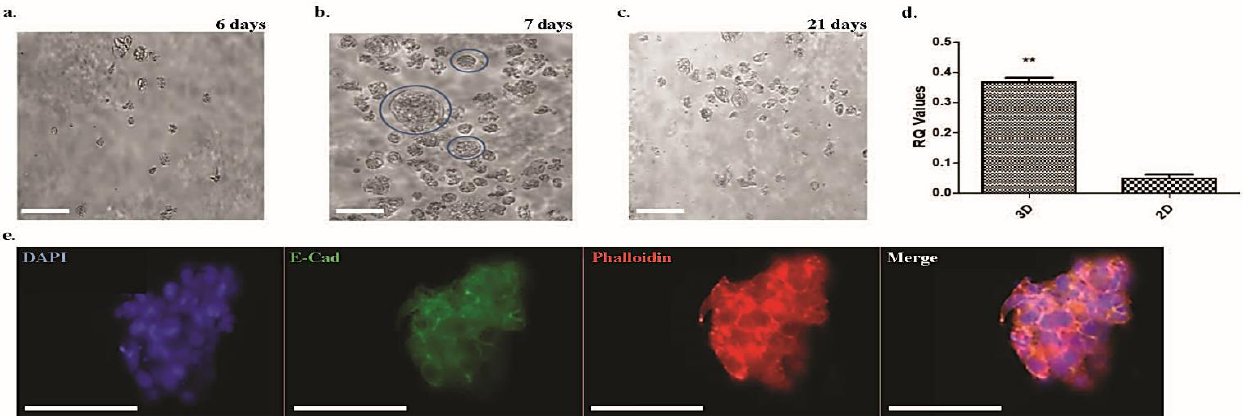
Figure 2. Brightfield images of 3D BeWo cells grown in Growdex (Helsinki, Finland) at different stages of growth. Cells were seeded at 80,000 cells/mL. Rows of cells imaged at 6 ( a ), 7 ( b ), and 21 ( c ) days. Cells appear to grow in clusters and form rounded multinucleated ring structures (blue circles in ( b )). Relative expression of syncytin-2 in nonsyncytialized BeWo cells grown for 7 days in 3D (Growdex) versus nonsyncytialized BeWo cells grown in 2D; ** p < 0.01 ( d ). Immunofluorescent images of 3D BeWo cells grown on Matrigel ( e ); E-Cad: E-cadherin; scale bars, 25 μm.